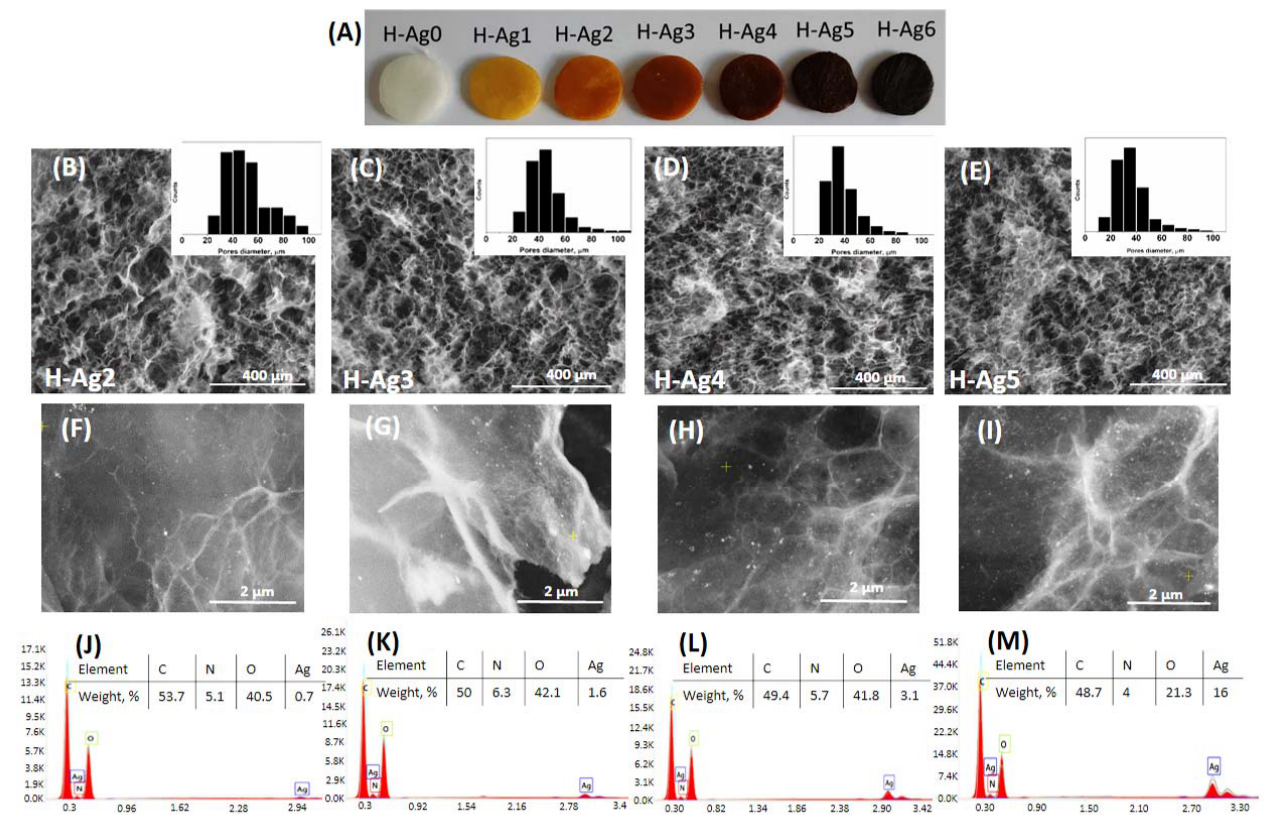
Figure 6. Optical images of the hydrogels with increased silver content ( A ). SEM images (cross- section) at 250 × magnification together with the corresponding pore distribution diagrams ( B – E ). SEM images at 10,000 × magnification, and the energy-dispersive X-ray spectroscopy (EDX) spectra of the lyophilized hydrogels with different contents of AgNPs: H-Ag2 ( B , F , J ), H-Ag3 ( C , G , K ),